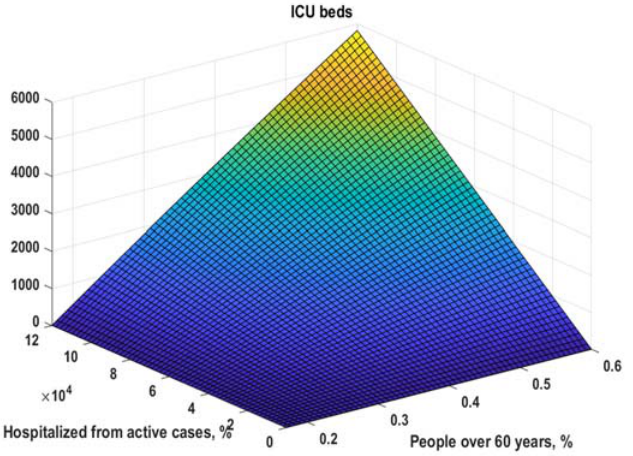
Figure 8. Model for the number of ICU beds (11). NOTE: Hospitalizations = all currently hospitalized patients, not daily new hospitalizations. The same is for ICU beds. All calculations here are for 21-day moving averages.